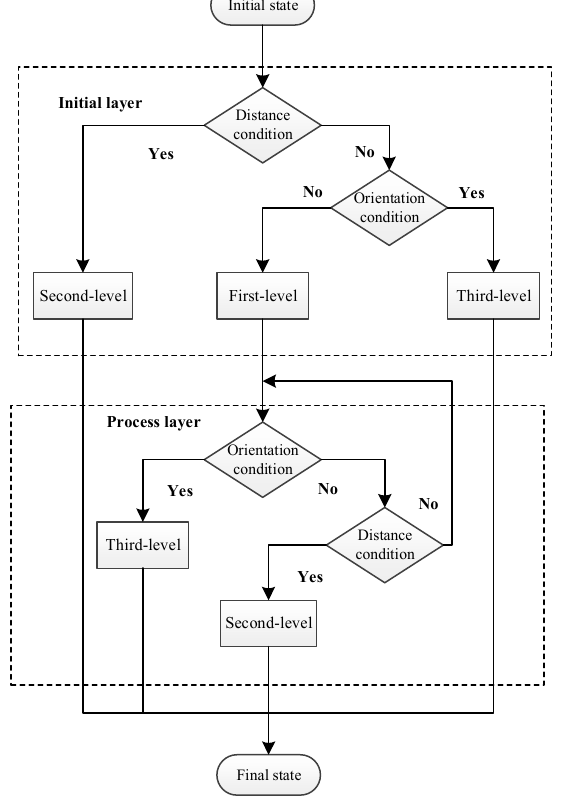
Figure 3. Flow chart of the HPS.